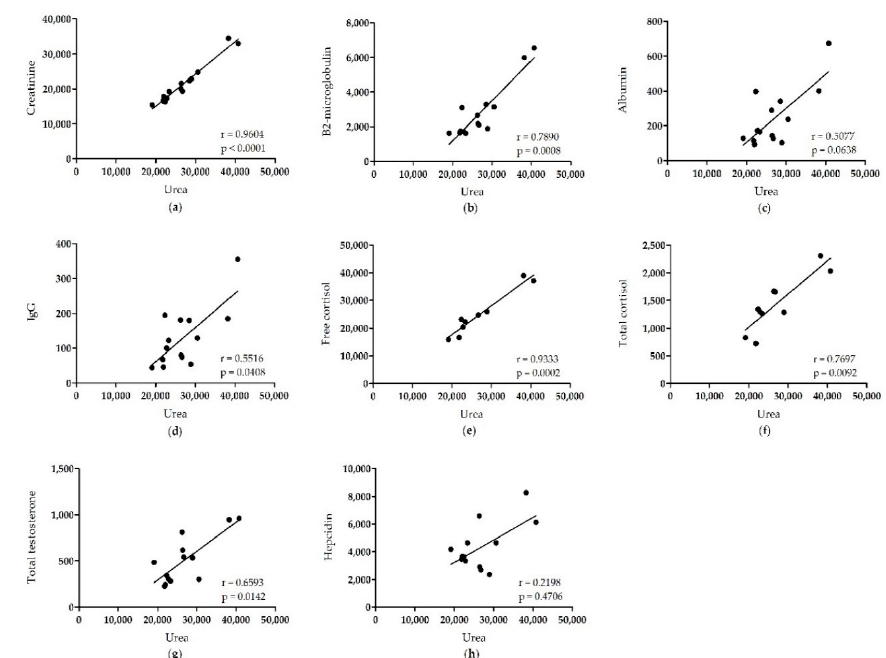
Figure 2. Correlations among the peritoneal clearance of urea with all analytes in patients with end-stage renal disease undergoing a peritoneal equilibration test. The peritoneal clearance of urea was correlated to the peritoneal clearance of ( a ) creatinine, ( b ) β 2-microglobulin, ( c ) albumin, ( d ) IgG, ( e ) free cortisol, ( f ) total cortisol, ( g ) total testosterone, and ( h ) hepcidin. The strength of the correlation was measured using Spearman’s correlation coefficient (r).